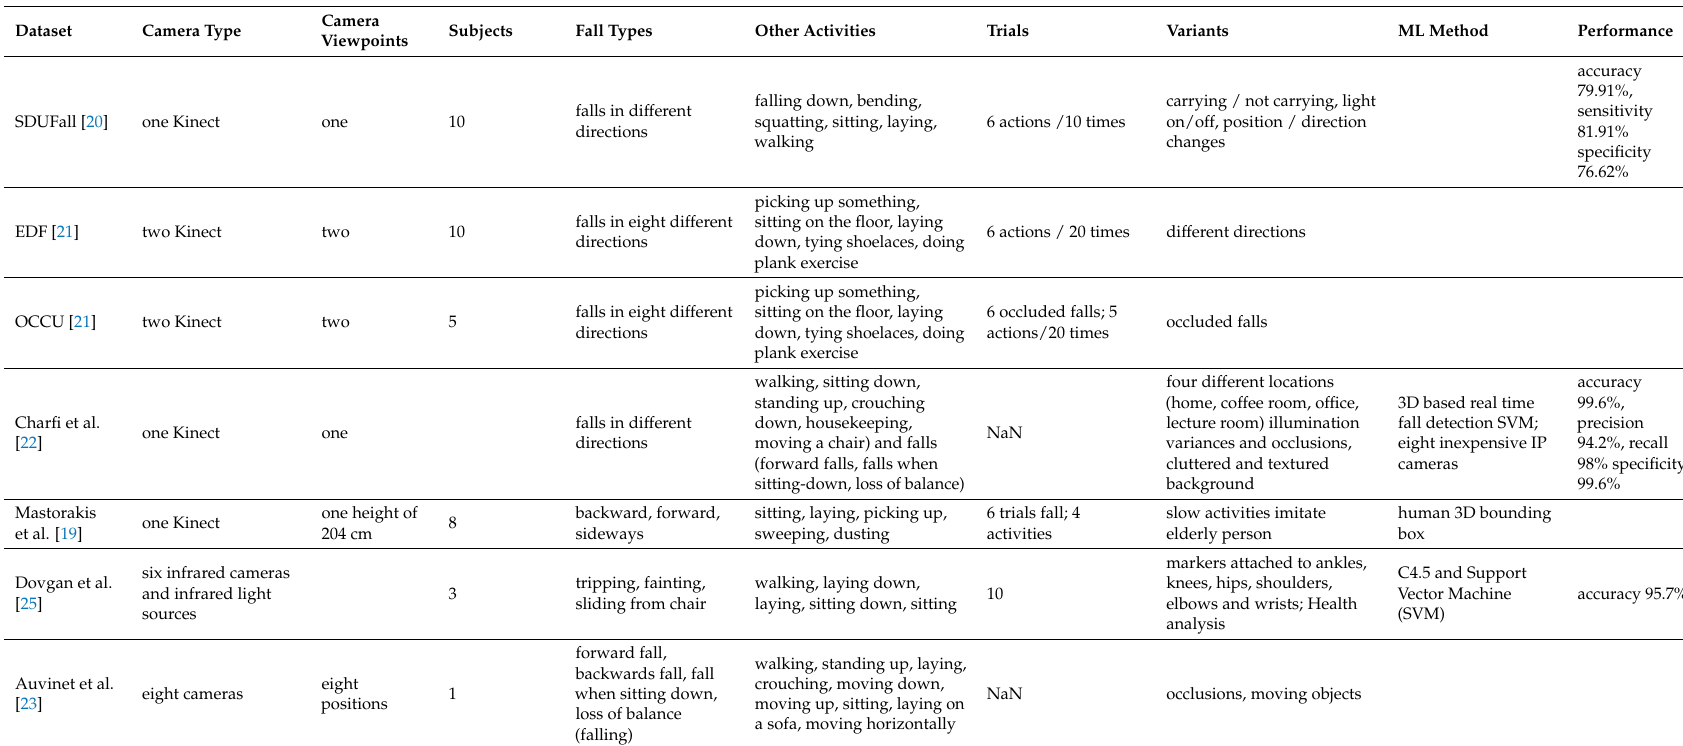
Table 2. Vision-based datasets for fall